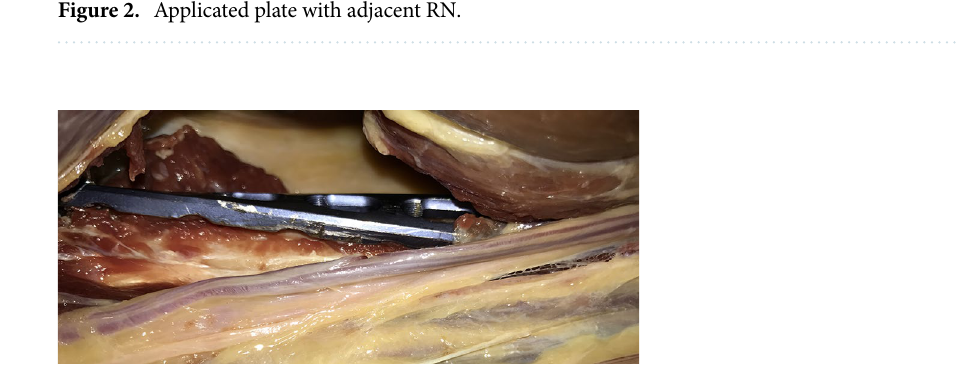
Figure 2. Applicated plate with adjacent RN.